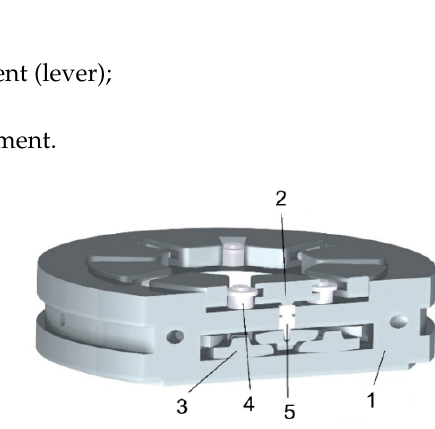
Figure 2. Self-equalizing bearing with levers (1—bearing body/housing, 2—thrust pad, 3—self- equalizing element (lever), 4—nozzle, 5—floating pressure element).